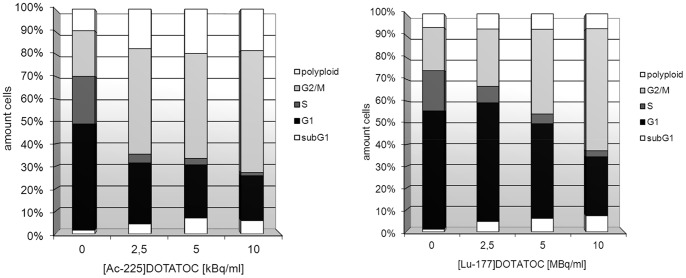
Cell-cycle distribution of AR42J cells at 48 h after incubation with 225Ac-DOTATOC (left) and 177Lu-DOTATOC (right) (SD <15%).